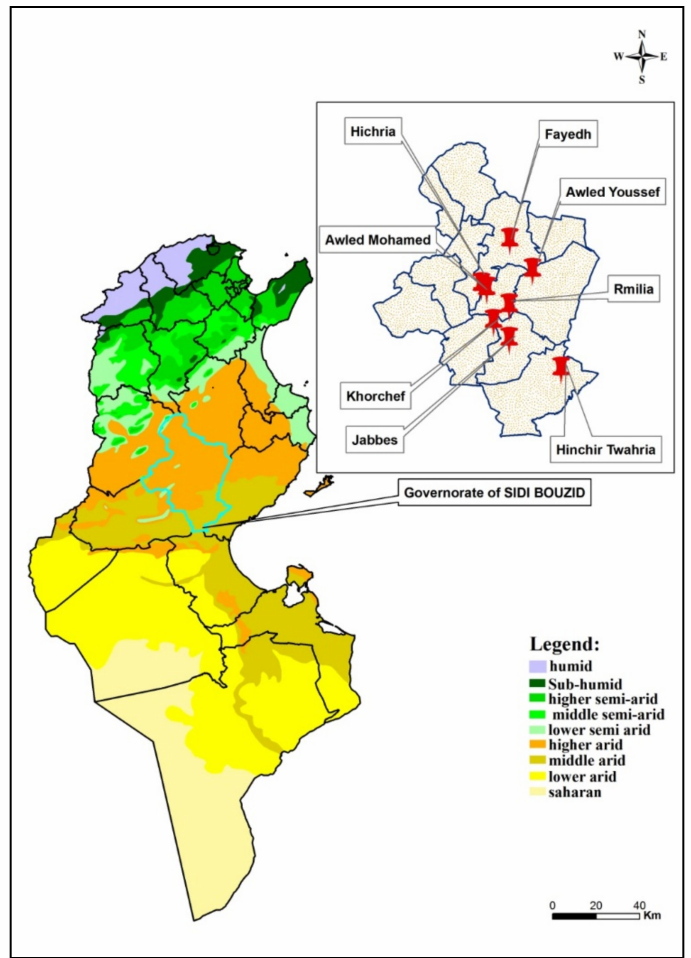
Figure 1. Bioclimatic map of Tunisia showing sampling sites in the governorate of Sidi Bouzid.